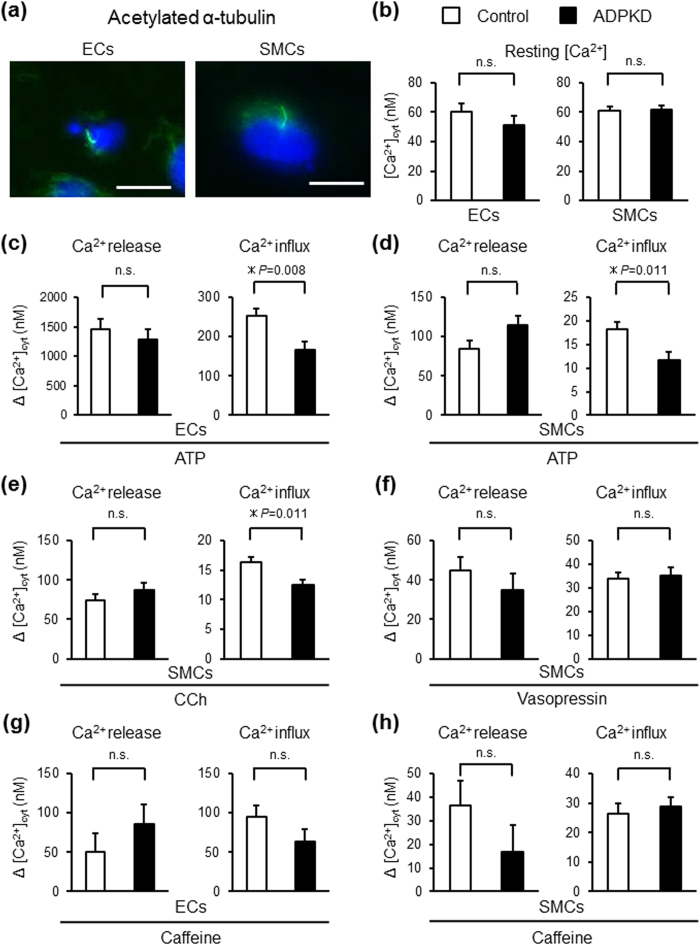
Intracellular Ca2+ Regulation in Vascular Endothelia and Smooth Muscle Cells Derived from Control- and ADPKD-iPSCs.(a) Anti-acetylated α-tubulin immunostaining of vascular endothelia (ECs) on culture day 12 and smooth muscle cells (SMCs) on day 25 differentiated from P4-iPSCs shows primary cilia (green). (b) The resting cytosolic Ca2+ concentration of ECs and SMCs derived from control-iPSCs (white bars) and ADPKD-iPSCs (black bars). (c–h) ATP (c,d), carbachol (CCh) (e), vasopressin (f) and caffeine (g,h) induced Ca2+ release and influx in ECs (c,g) and SMCs (d–f,h) derived from control- and ADPKD-iPSCs. Ten control- and seven ADPKD-iPSC lines and eight to ten control- and seven ADPKD-iPSC lines were used for the analyses of ECs (b,c,g) and SMCs (b,d–f,h), respectively. The results are expressed as the means ± SEM. *Statistically significant, n.s.; not significant. See also Tables S4 and S5.